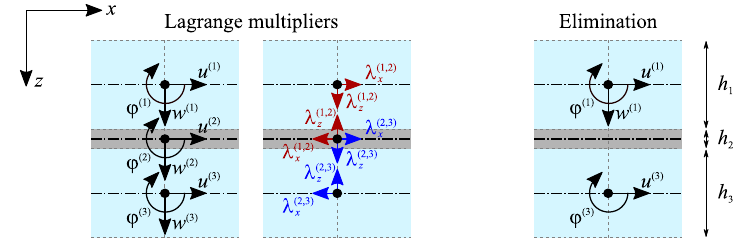
Fig. 4 Degrees of freedom per cross-section of laminated glass using Lagrange multipliers or